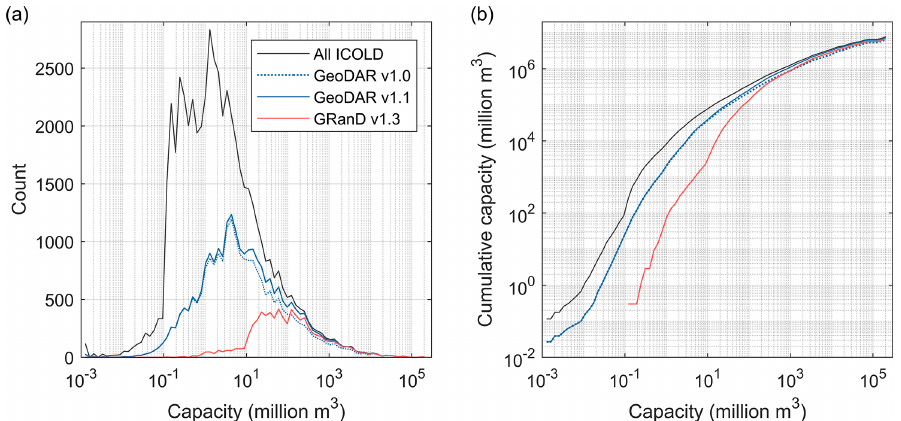
Figure 9. Comparison among GeoDAR, the ICOLD WRD, and GRanD by reservoir storage capacity. (a) Frequency (count) distribution. (b) Cumulative (integral) storage capacities. Statistics were based on 80 equal-size bins (except the initial bin) on a logarithmic scale between the minimum and maximum storage capacities (i.e., 0 to 2 . 05 × 10 5 mcm).